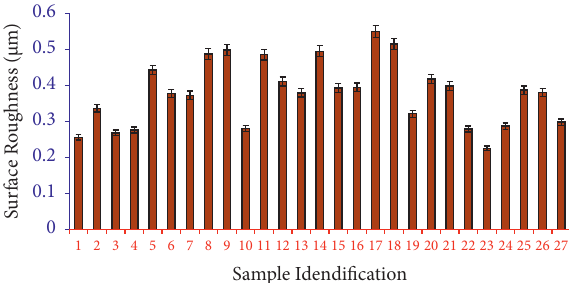
Figure 5: SEM images after the abrasion